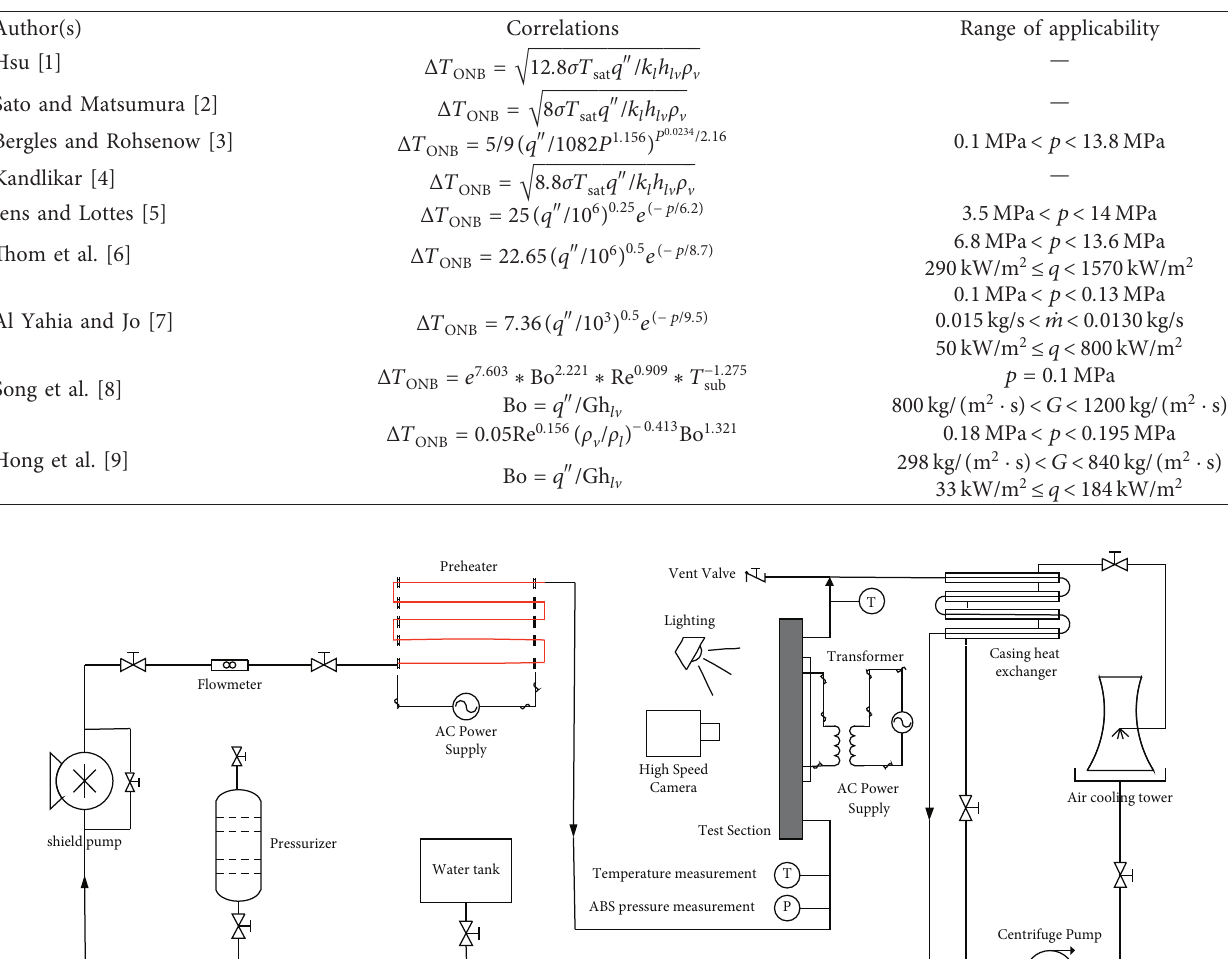
Table 1: ONB models in the literature.